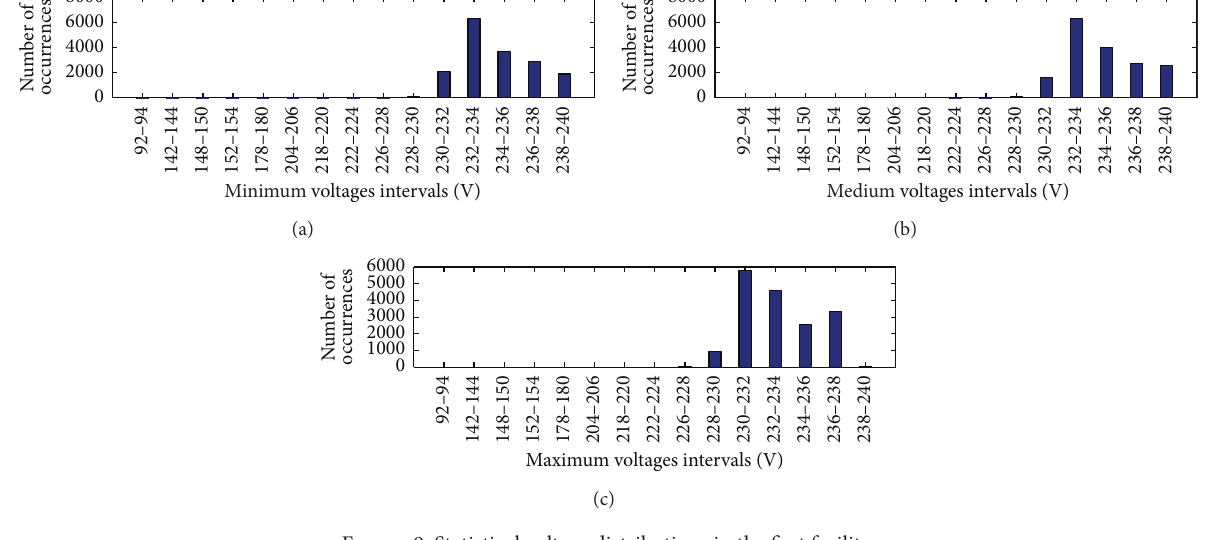
Figure 9: Statistical voltage distributions in the first facility.